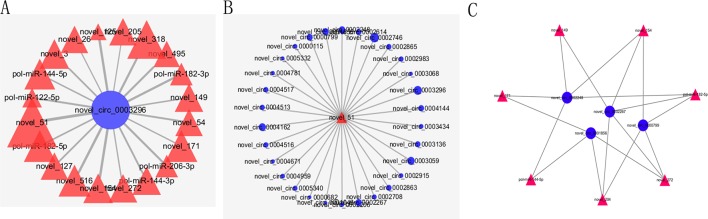
Partial circRNA–miRNA regulatory network. CircRNAs and miRNAs are indicated by blue circle and red triangle, respectively. (A) The miRNAs combined with novel_circ_0003296. (B) The circRNAs combined with novel_51. (C) The PPI network consisting of hub genes.